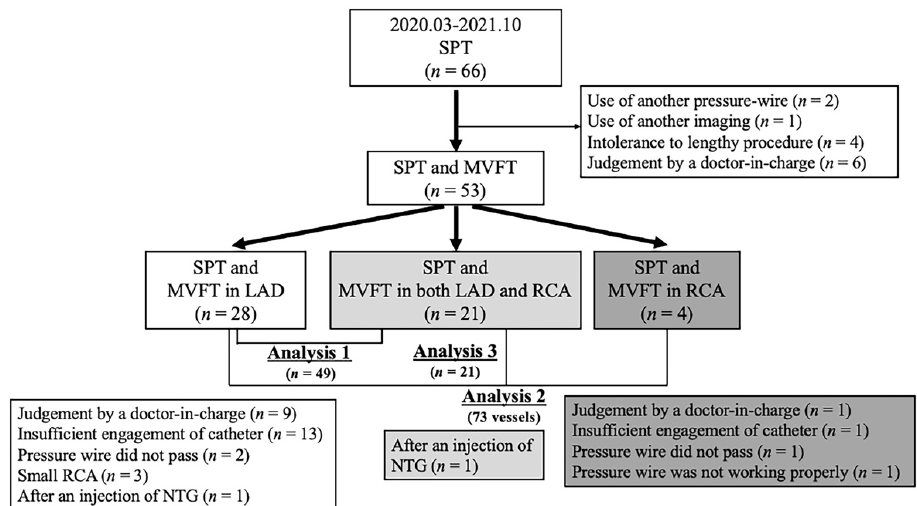
Figure 1. This is a figure of the study flowchart. Analysis 1 examined the relationship between the clinical parameters and IMR in 49 patients in whom MVFT data could be obtained in the LAD. Analysis 2 examined the relationship between MVFT data and lesion characteristics in 73 coronary vessels. Analysis 3 compared MVFT data between LAD and RCA in 21 patients in whom MVFT data could be obtained in both the LAD and RCA. LAD, left anterior descending coronary artery; MVFT, microvascular vasodilatory function test; NTG, nitroglycerin; RCA, right coronary artery; SPT, spasm provocation